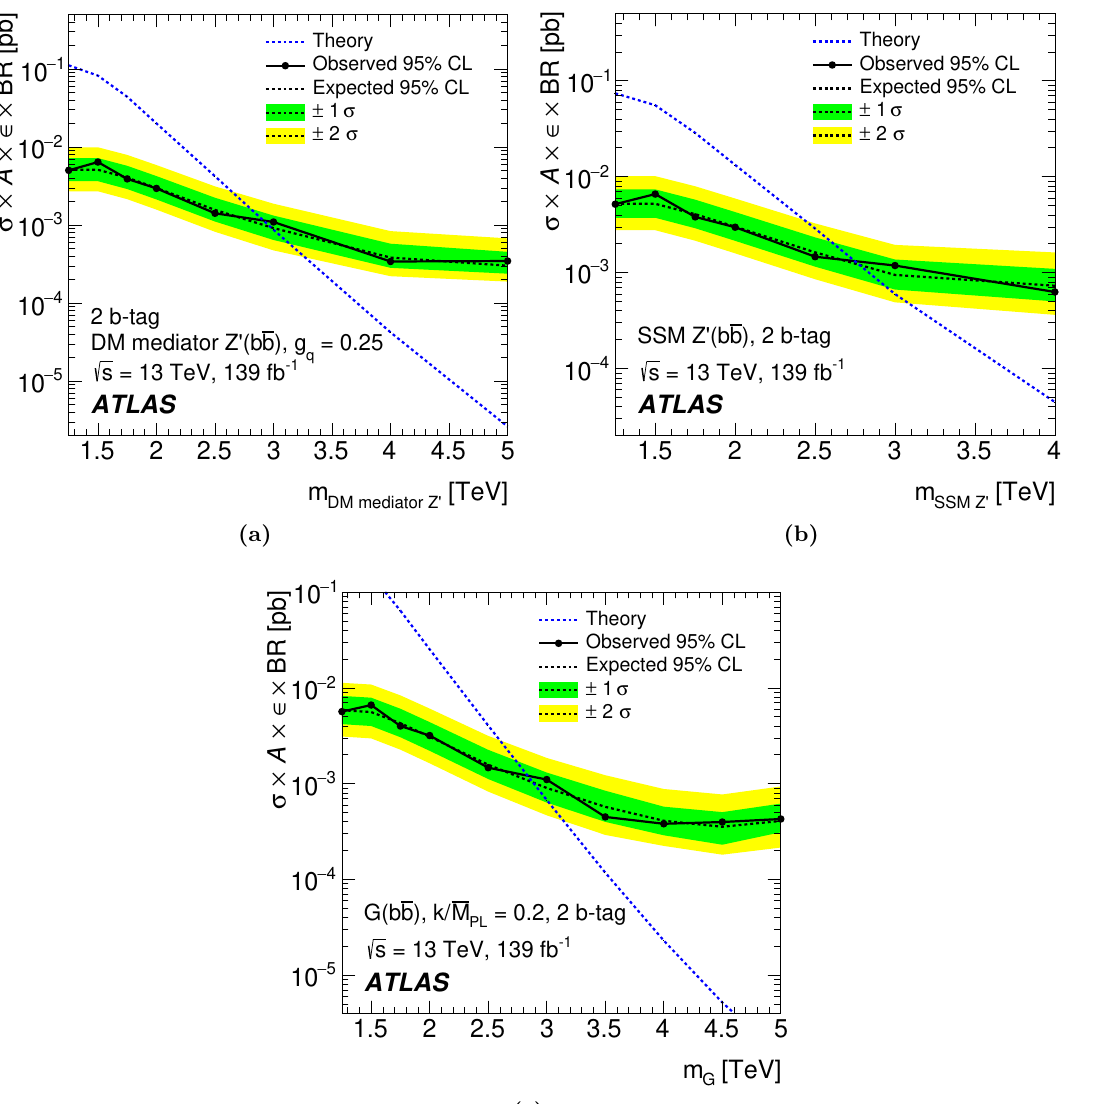
Figure 7 . The 95% CL upper limit on the cross-section times acceptance times b -tagging e(cid:14)ciency times branching ratio as a function of the signal mass in the (a) DM mediator Z 0 with g = 0 : 25, q (b) SSM Z 0 and (c) graviton with k=M = 0 : 2 models. The expected limit and corresponding PL (cid:6) 1 (cid:27) and (cid:6) 2 (cid:27) uncertainty bands are also shown. These exclusion limits are obtained using the 2 b category, with the selection described in the text and summarised in table 1.